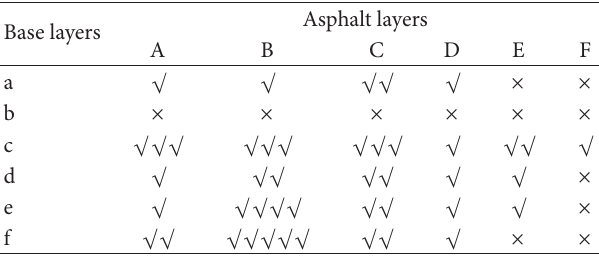
Table 3: Recommended asphalt pavement